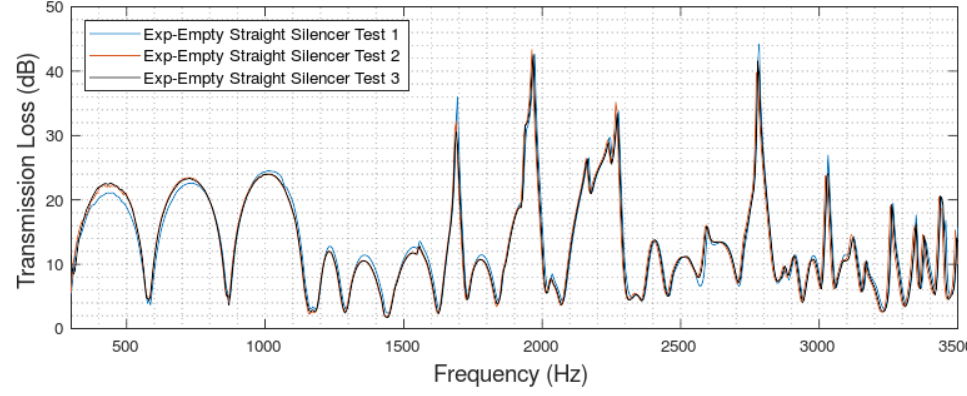
Figure 12. Two-load test rig experimental